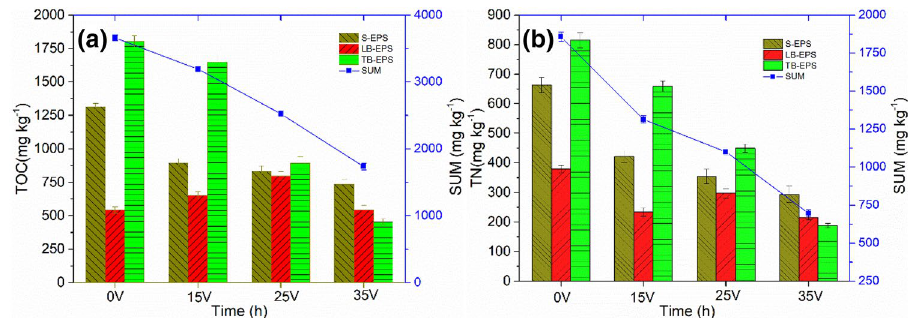
Figure 4. ( a ) TOC and ( b ) TN content in sludge after